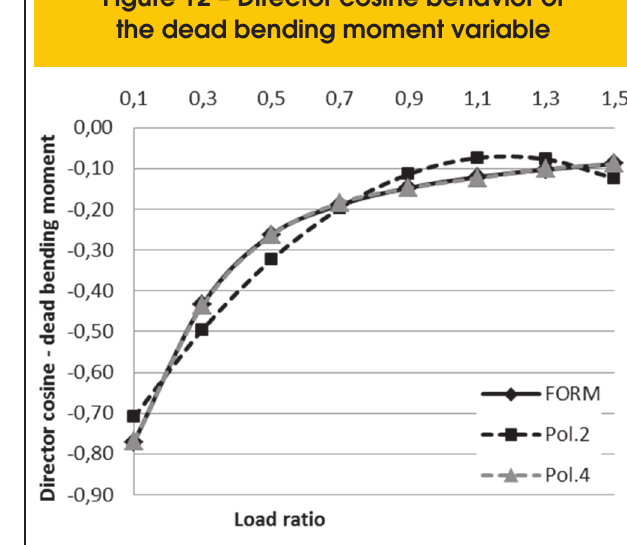
Figure 10 – Director cosine behavior Figure 12 – Director cosine behavior